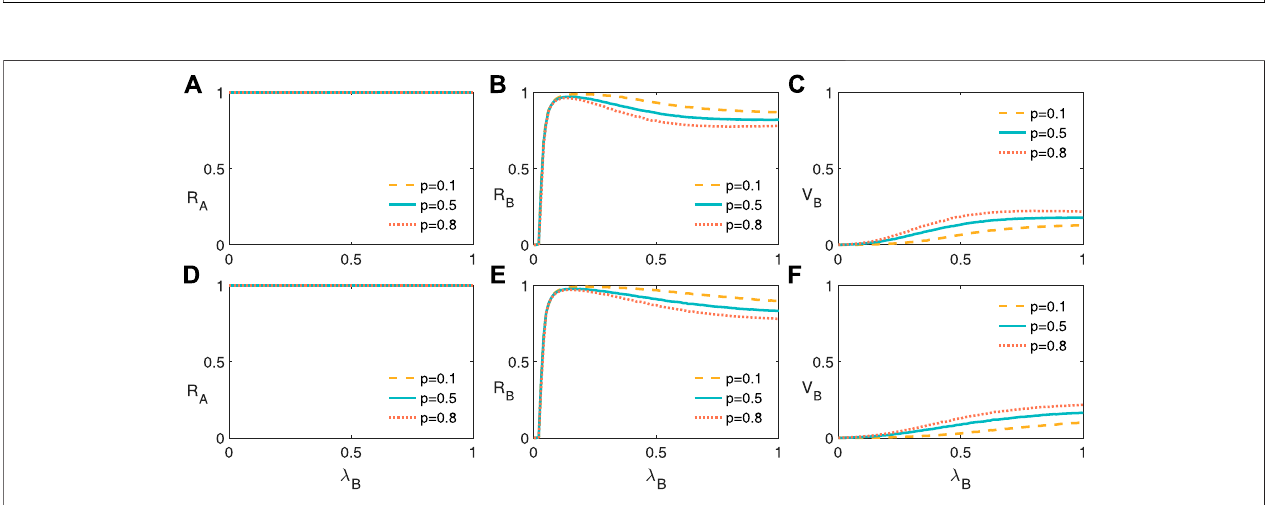
FIGURE 5 | (Color online) The fi nancial risk spreading on two-layer networks for a given values of fi nancial risk transmission probability. Final information spreading size R A (A) , fi nal fi nancial risk spreading size R B (B) , and vaccination size R B (C) versus information transmission probability λ B with fi nancial risk transmission probability λ A =0.5. R A (D) , R B (B) ,and R B (C) versus and φ =